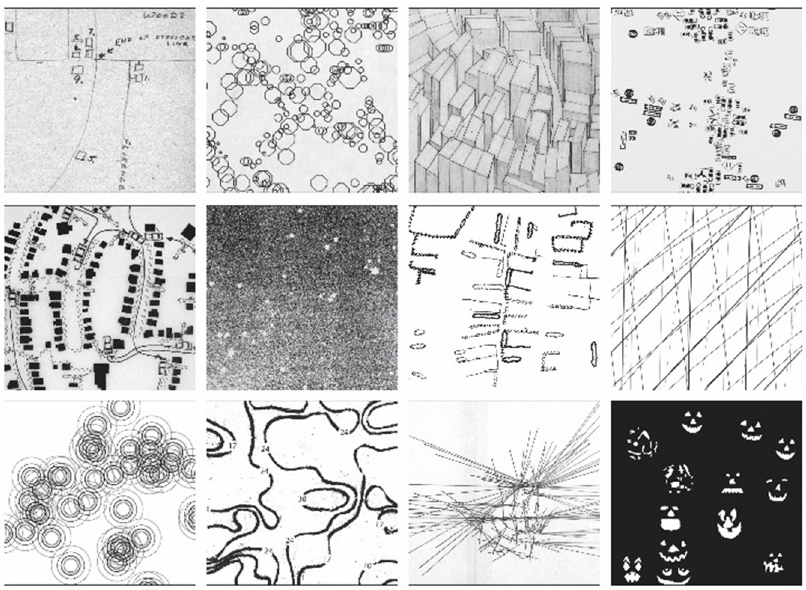
Figure 3. Front endpaper of Everything Sings ([5], used with